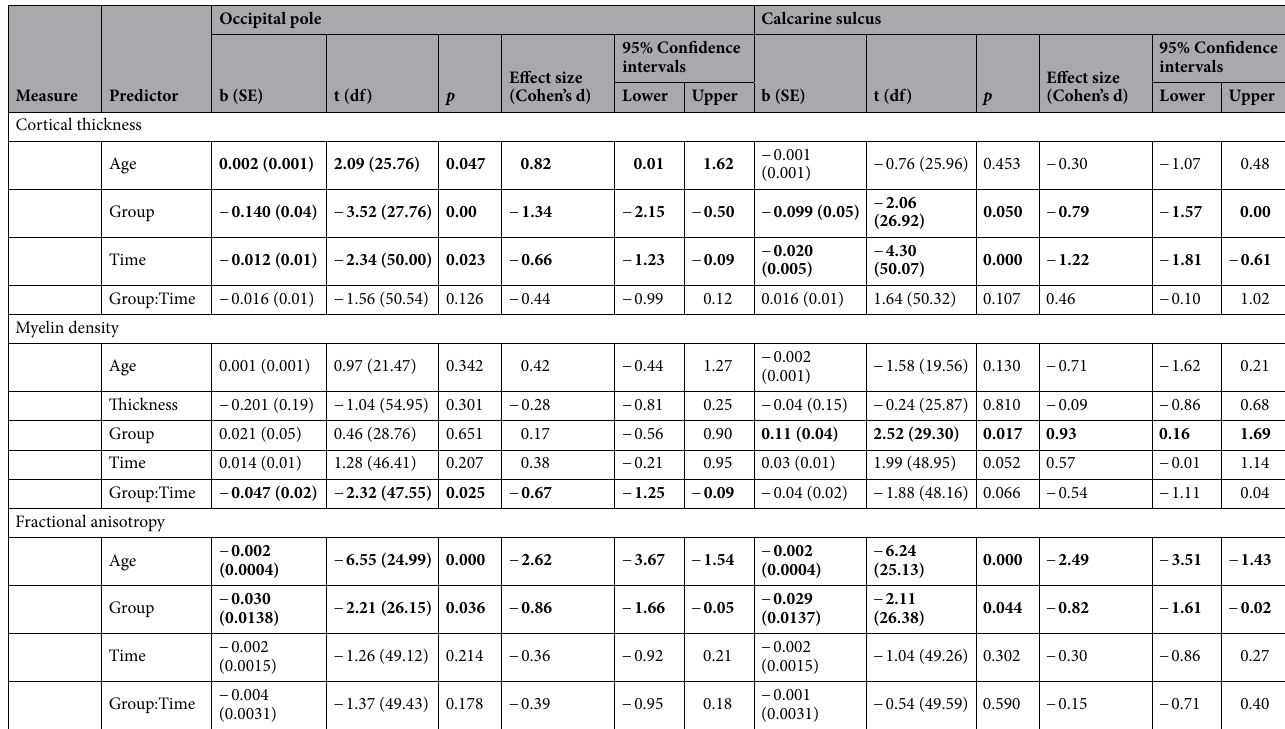
Table 2. Model output from the Linear Mixed Effects Models assessing changes in cortical thickness, myelin density and fractional anisotropy between MD patients and controls over time. Here we are reporting the fixed effects with the standard error (SE) for the predictors we used for each ROI (occipital pole and calcarine sulcus). Age refers to the age of participants at the first time point. Group refers to MD patients and sighted controls. Time refers to the time in years since the baseline scan was conducted. Thickness in the Myelin Density section refers to cortical thickness. T test results determine the significance of each of the predictors reported here. Estimates for effect size (Cohen’s D) and corresponding 95% confidence intervals are reported. All significant results are in